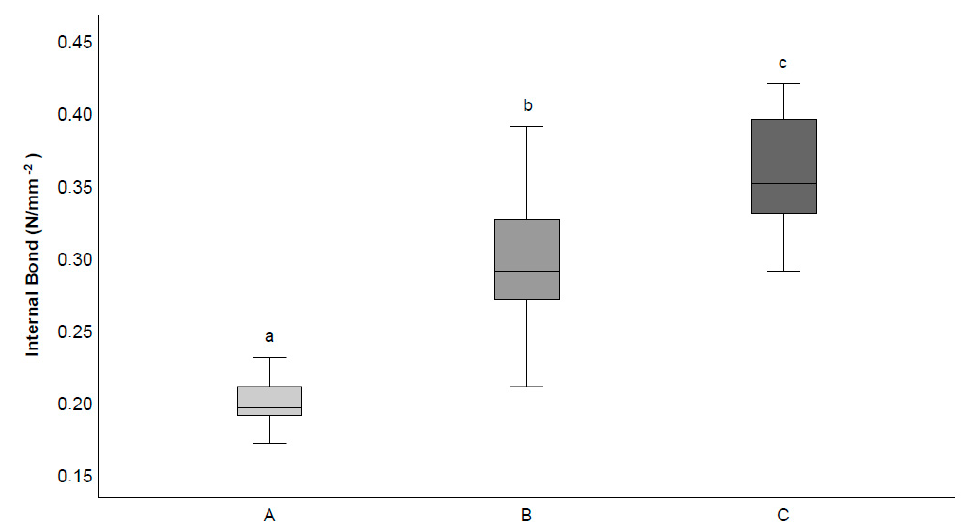
Figure 3. Internal bond of the OSB types [percentages of sweet chestnut wood (SC) and poplar (P) wood: A: 50% SC-50% P; B: 60% SC-40% P; C: 100% SC] measured according to EN 319, and grouped (a, b, c) based on statistical analysis (T-bars indicate maximum and minimum values).